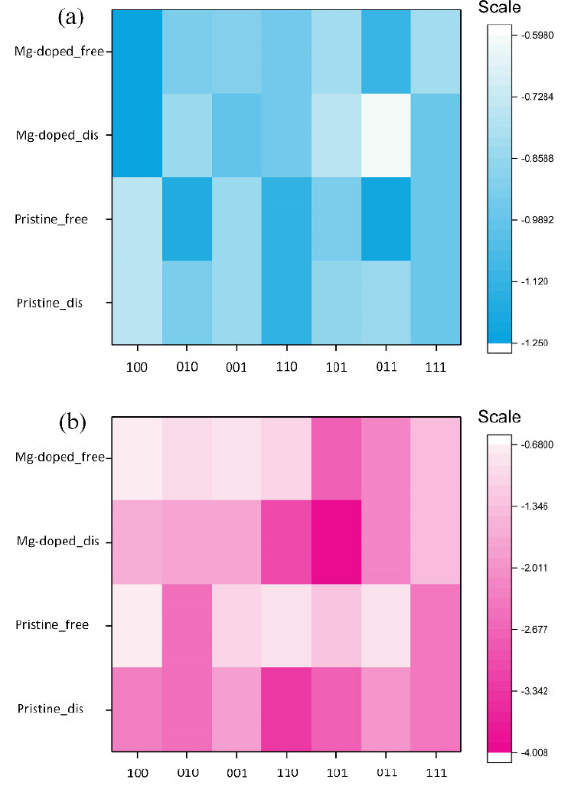
Figure 7. Comparison of E ad of a single water molecule on pristine and Mg-doped surfaces of: ( a ) β -C 2 S, and ( b ) M3-C 3 S. Note: the dis and free in the y -axis represents dissociated water and free water in the initial configuration.